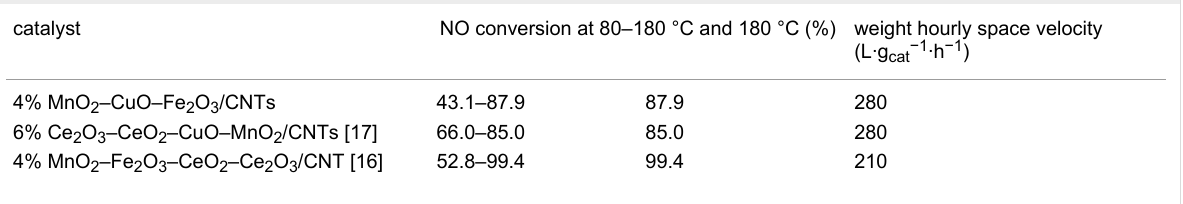
Table 1: Catalytic performance of three